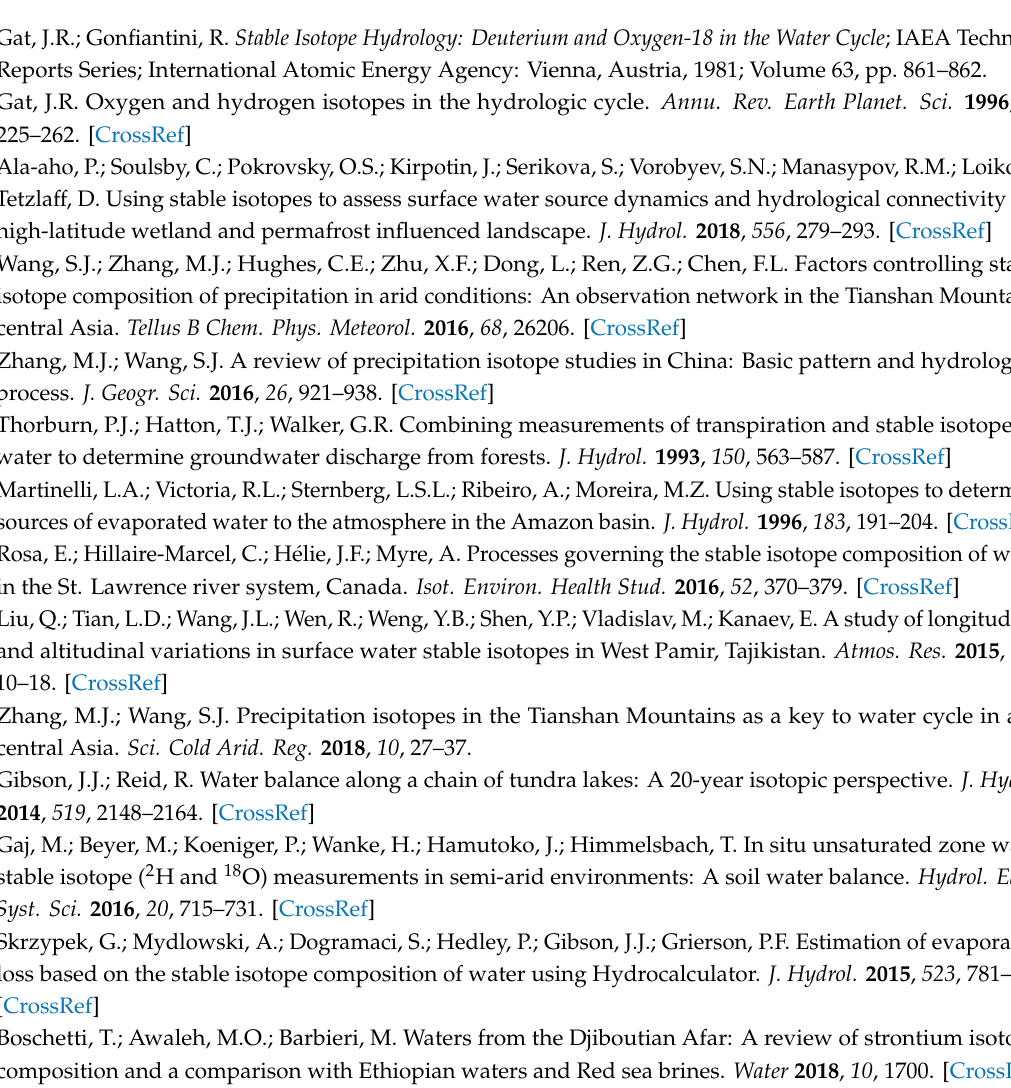
Figure S1: The variation of original and detrended D-excess in (a) the lake water and (b) the river water, Table S1: Inventory of surface water isotopes in the Liujiaxia Reservoir from 2016 to